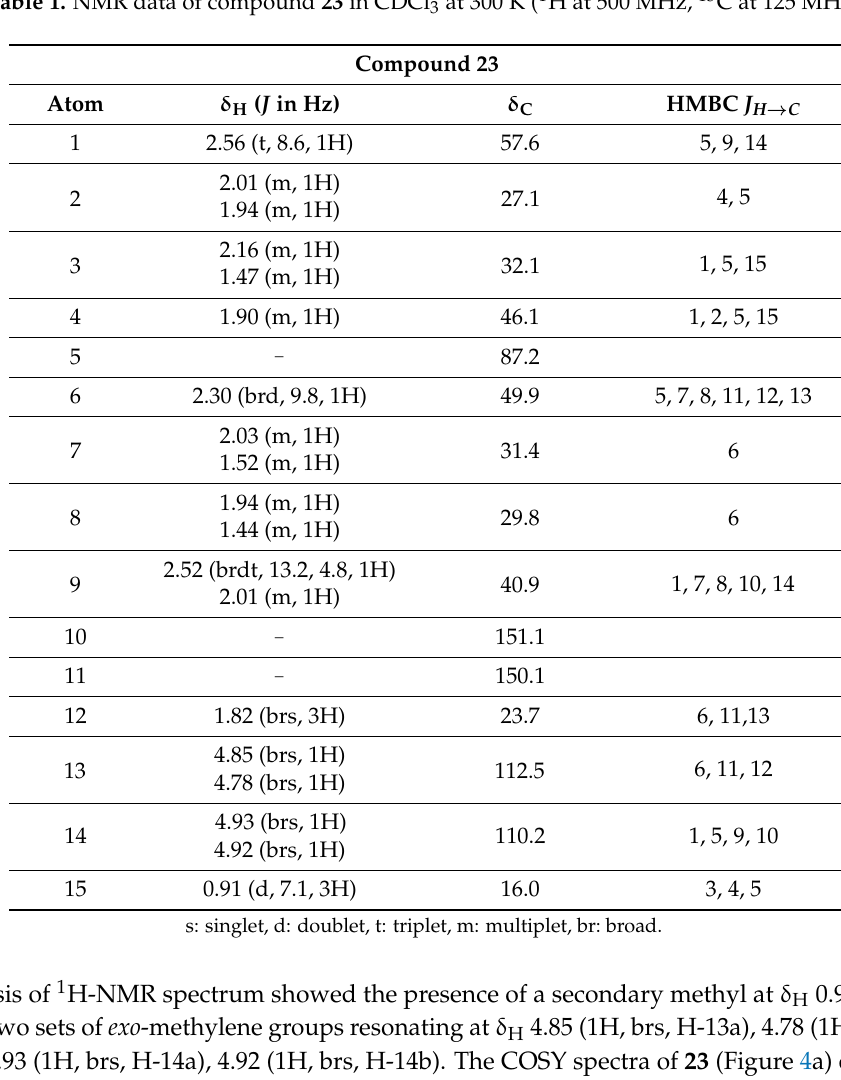
1.94 (1H, m) and δ H 1.44 (1H, m), H-7 at δ H 2.03 (1H, m) and δ H 1.52 (1H, m) and H-6 at δ H 2.30 (1H, brd, 9.8), the HMBC correlation between H-6 and C-5 at δ C 87.2, and the correlations between H-14 at